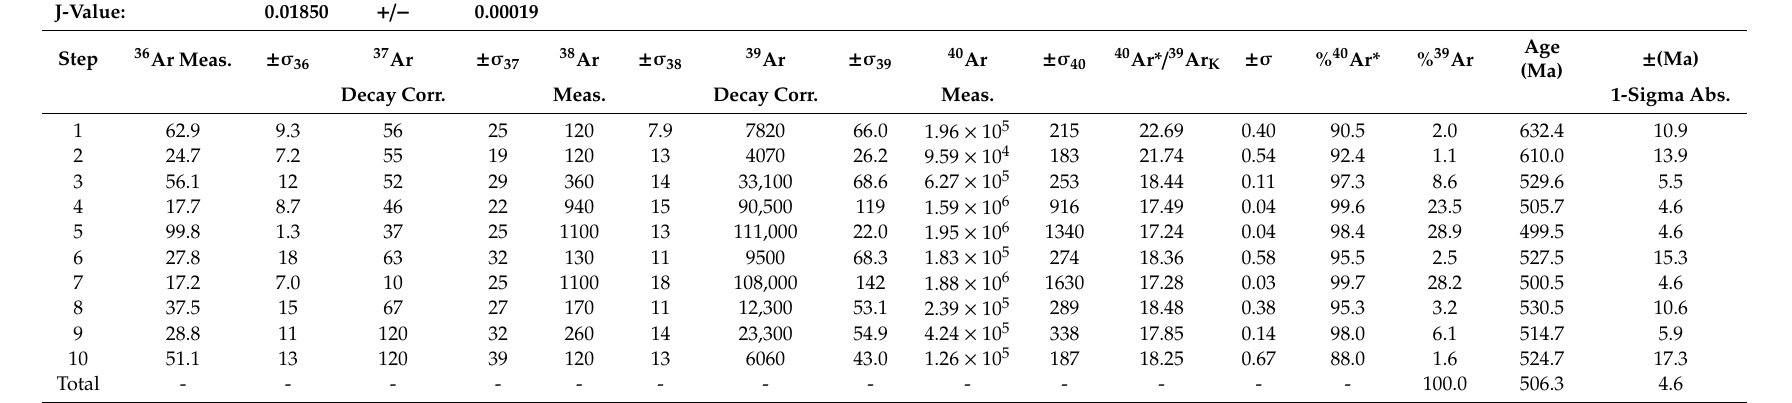
Table 2. The experimental results of 40 Ar / 39 Ar analytical